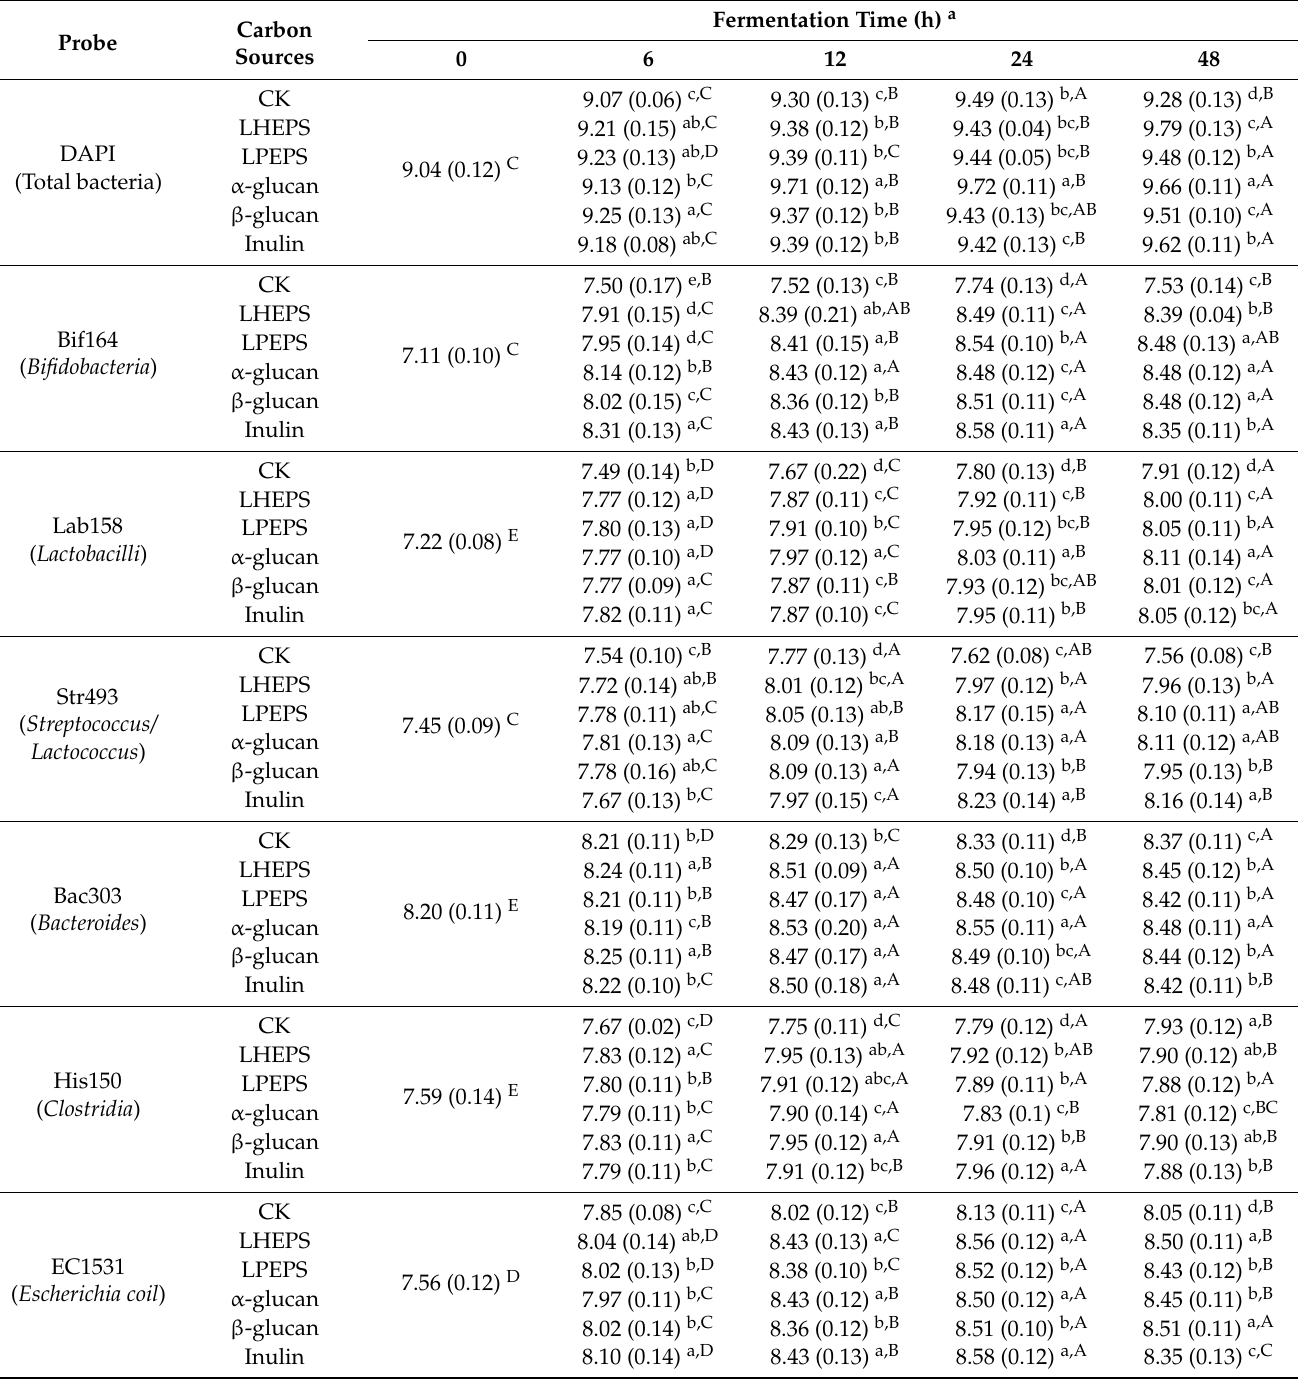
Table 1. Changes in the bacterial populations (log 10 cells/mL) in vitro fermentation at 0 (inoculum), 6, 12, 24, and 48 h using five kinds of pure polysaccharides, in comparison to a no treatment control ( n = 3) a